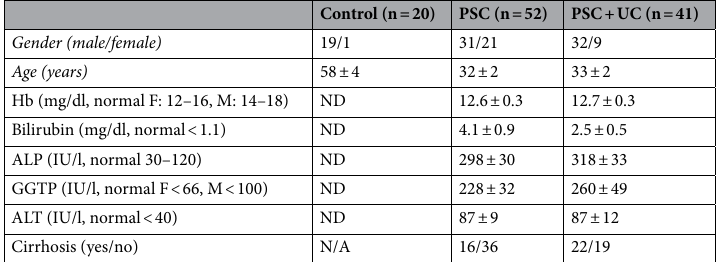
Table 3. Demographic and laboratory features of patients in whom only S1P serum concentration were analyzed. Values are given as mean ± SD, unless stated otherwise. PSC primary sclerosing cholangitis, UC ulcerative colitis, Hb hemoglobin, ALP alkaline phosphatase, GGTP gamma-glutamyl transferase, ALT alanine aminotransferase, SD standard deviation, N/A not applicable, ND no